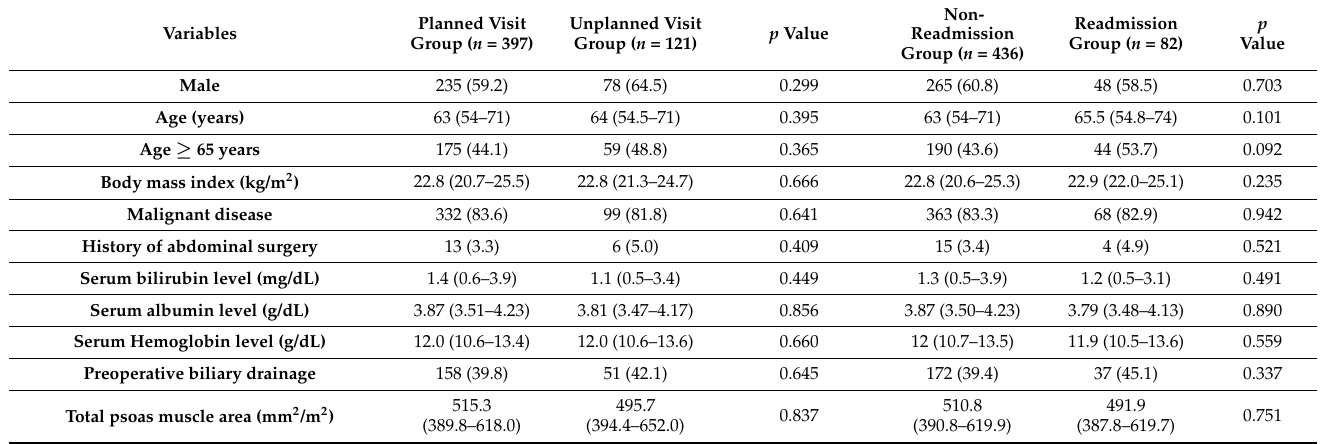
Table 2. Clinical demographics of patients categorized by unplanned hospital visit or